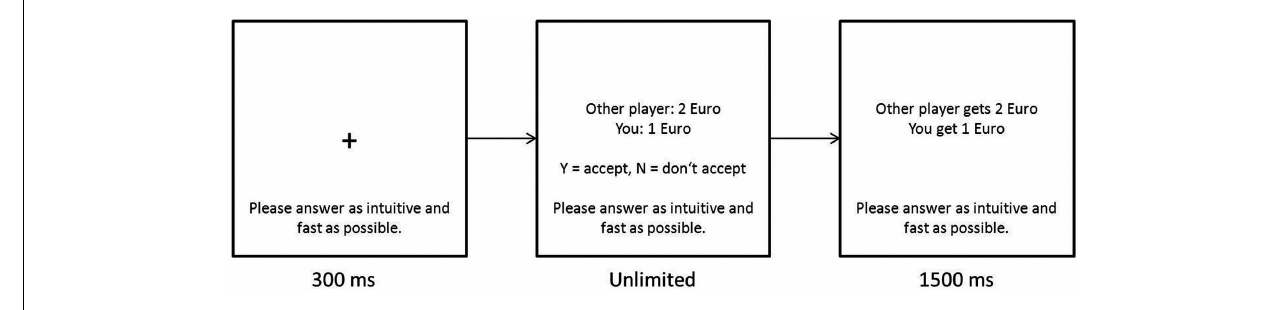
FIGURE 1 |The design of the computerized ultimatum